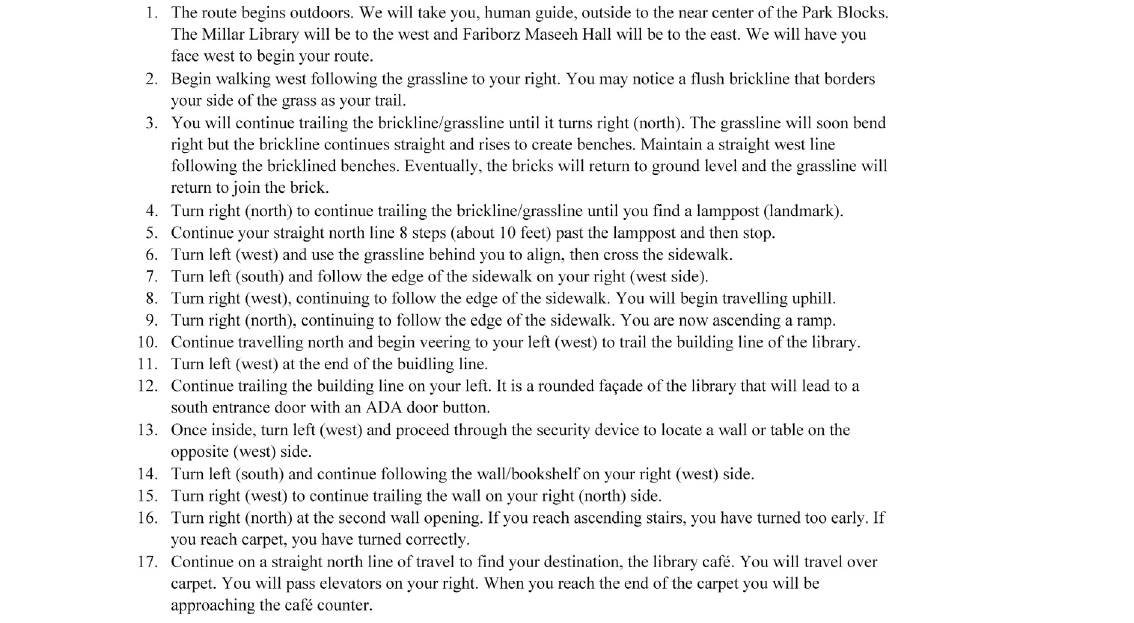
FIGURE 5 | Route description for Route B that was read to the participant during the route preview phase. Subsequently, a digital fi le of the route description was sent to the participant through email for use during the way fi nding experience using Apple VoiceOver on the participant ’ s iPhone.